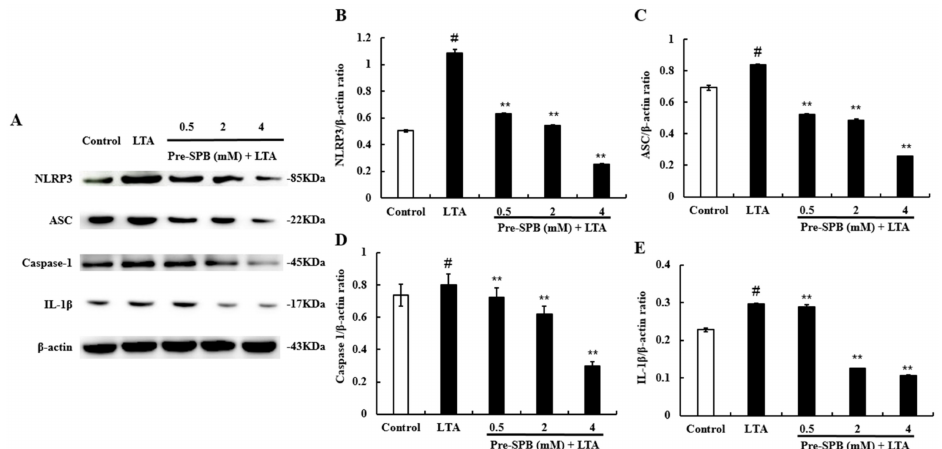
Figure 5. The effect of SPB on NLRP3 inflammasome. The NLRP3 inflammasome pathway was explored in MAC-T cells using Western blot analysis. β -actin was used as a reference control. ( A ) The expression levels of NOD-like receptor protein 3 (NLRP3), apoptosis-associated speck-like protein containing CARD (ASC), caspase-1, and interleukin 1 beta (IL-1 β ) proteins; ( B ) The quantification histogram of NLRP3 protein expression normalized by β -actin; ( C ) The quantification histogram of ASC protein expression normalized by β -actin; ( D ) The quantification histogram of caspase-1 protein expression normalized by β -actin; and ( E ) The quantification histogram of IL-1 β protein expression normalized by β -actin. The values presented are the means ± SE of three independent experiments. # p < 0.05 vs. control group; ** p < 0.01 vs. LTA